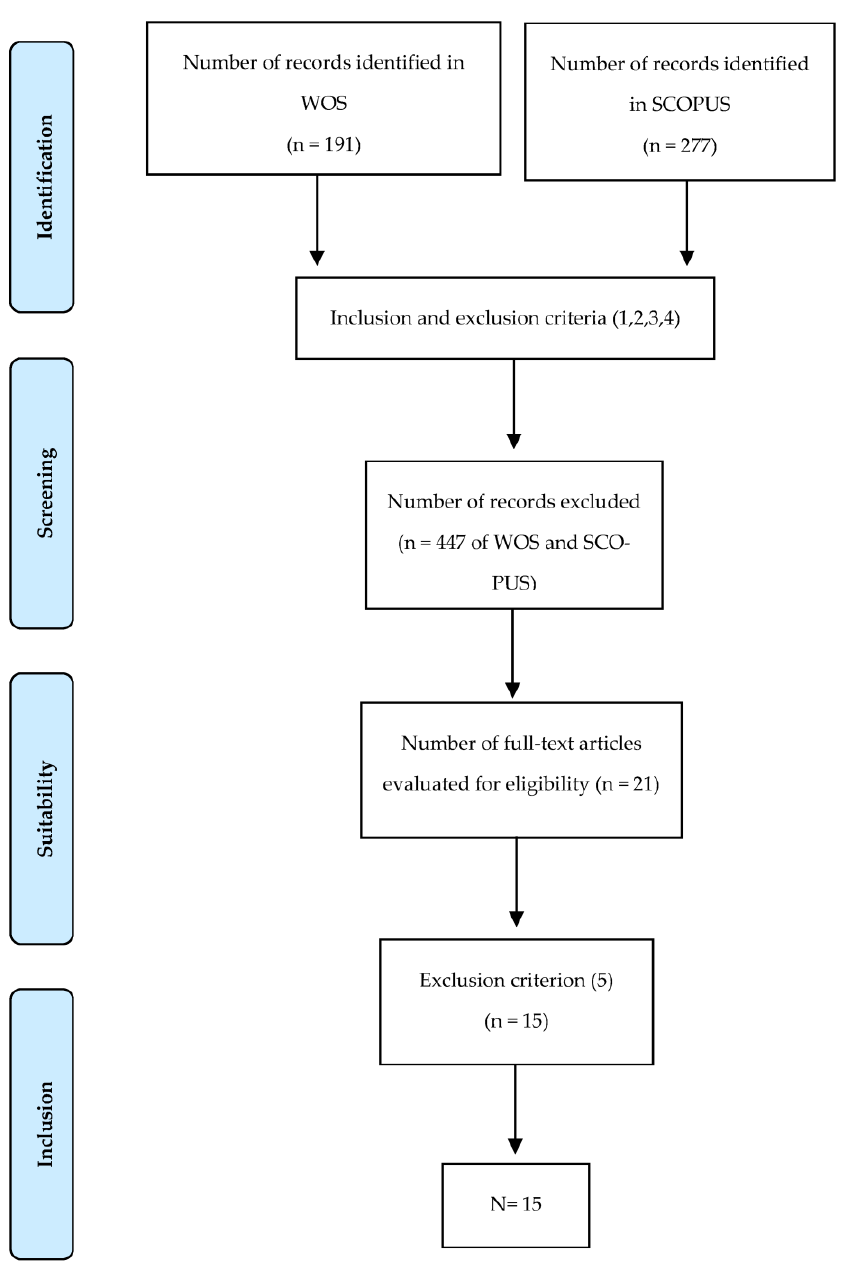
Figure 1. Figure 1. Flowchart.